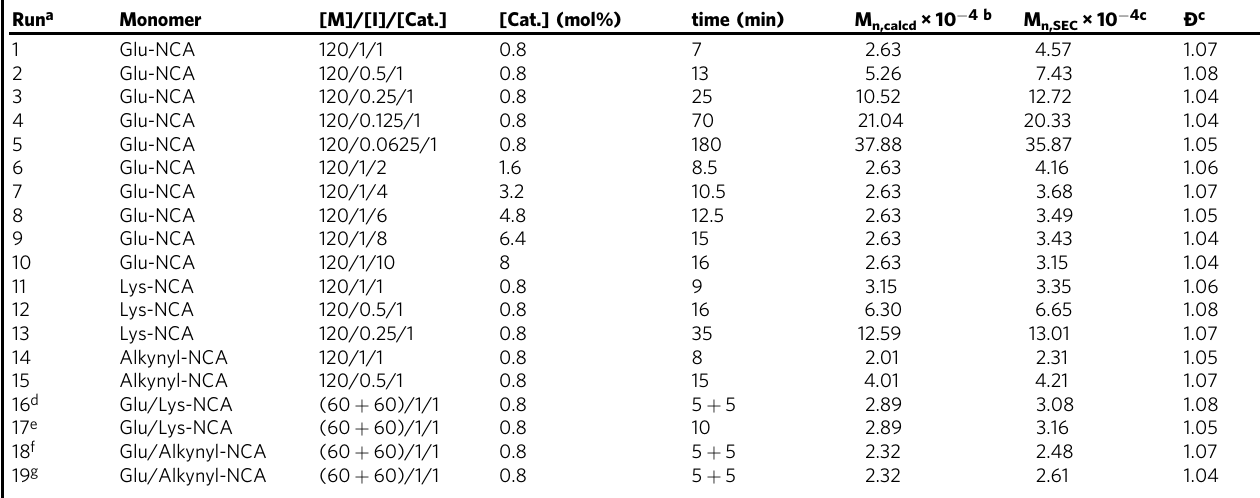
Table 1 Living polymerization of NCAs promoted by 1,3-Bis-HFAB Run